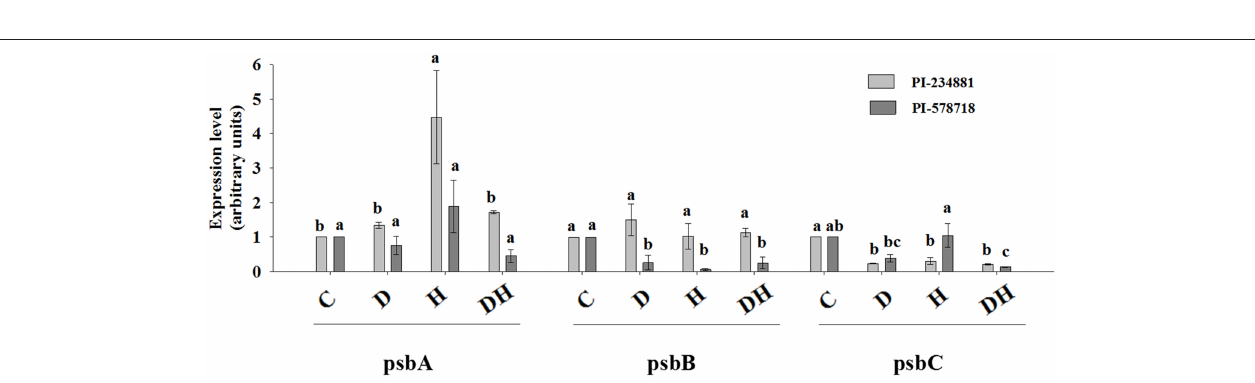
Frontiers in Plant Science | www.frontiersin.org